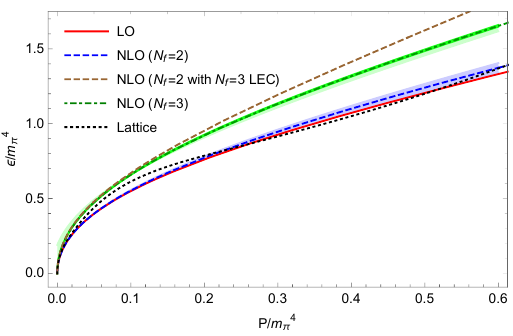
Figure 6 . Normalized energy density ( (cid:15)=(cid:22) 4 at NLO with two (cid:13)avors (blue), NLO with three (cid:13)avors (green), and NLO with two (cid:13)avors and three-(cid:13)avor LECs (brown). See main text for